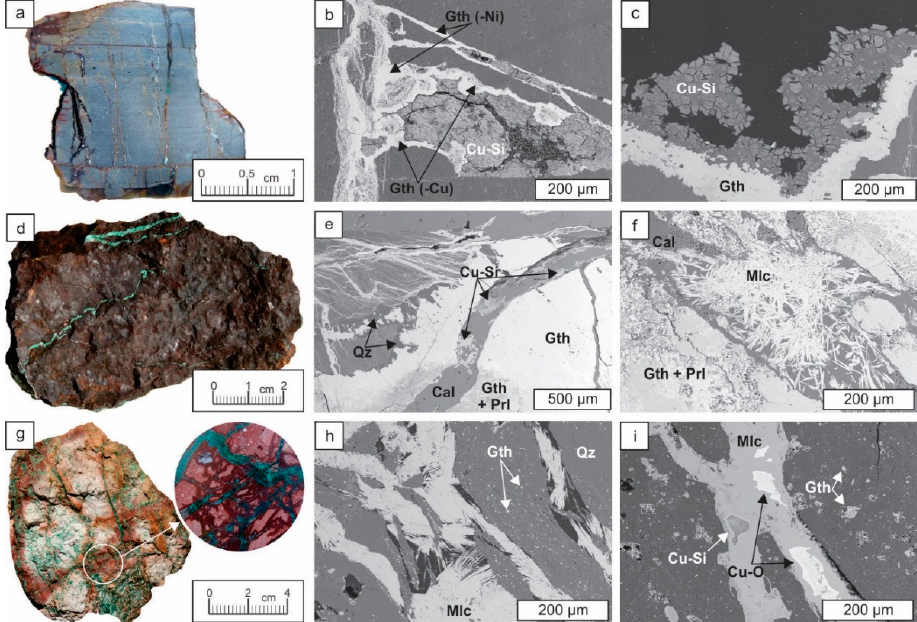
Figure 5. Cu mineralization ( b , c , e , f , h , i : SEM photomicrographs, in backscattered electrons mode). ( a ) Cu-veins in Paleozoic schist (polished section); ( b ) hydrated Cu-silicate (Cu-Si) in Ni- or Cu-rich goethite vein (Gth (-Ni) and Gth (-Cu)); ( c ) hydrated Cu-silicate (Cu-Si) covering goethite (Gth); ( d ) Cu-mineralized veins in goethite (and pyrolusite); ( e ) Cu-silicates of various compositions (Cu-Si) in a calcite (Cal) vein cutting quartz (Qz) and the intermixed goethite (Gth) and pyrolusite (Prl); ( f ) acicular malachite (Mlc) in calcite (Cal) vein cutting goethite (Gth) and pyrolusite (Prl); ( g ) Cu-mineralized veins in iron-rich Triassic conglomerate; ( h ) acicular malachite (Mlc) vein cutting through iron-rich conglomerate composed of quartz (Qz) and goethite (Gth); ( i ) hydrated Cu-silicate (Cu-Si) and Cu-oxides (Cu-O) in malachite (Mlc) veins cutting goethite (Gth)-rich conglomerate.